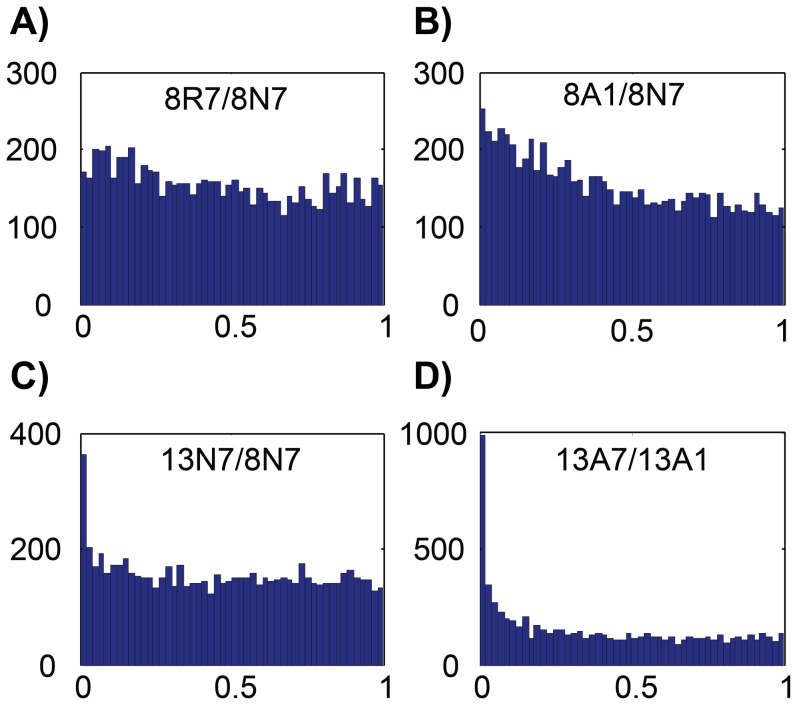
Bar-charts displaying types of p-value distributions for contrasts between selected treatments.A random distribution would be represented by an equal representation of p-values across the full range, generating a flat histogram, as in the 8R7/8N7 contrast, top left panel. In some contrasts, the proportion of genes with p<0.05 was much greater indicating a non-random distribution, as in the 13A7/13A1 contrast, bottom right panel. The proportion of these gene probes that were randomly included in this category (i.e. the false discovery rate) was estimated by backwards extrapolation of the horizontal line above p>0.2. The two other contrasts represent intermediate conditions in which DE genes were evident but were difficult to extract as significant due to large proportions of false positives.